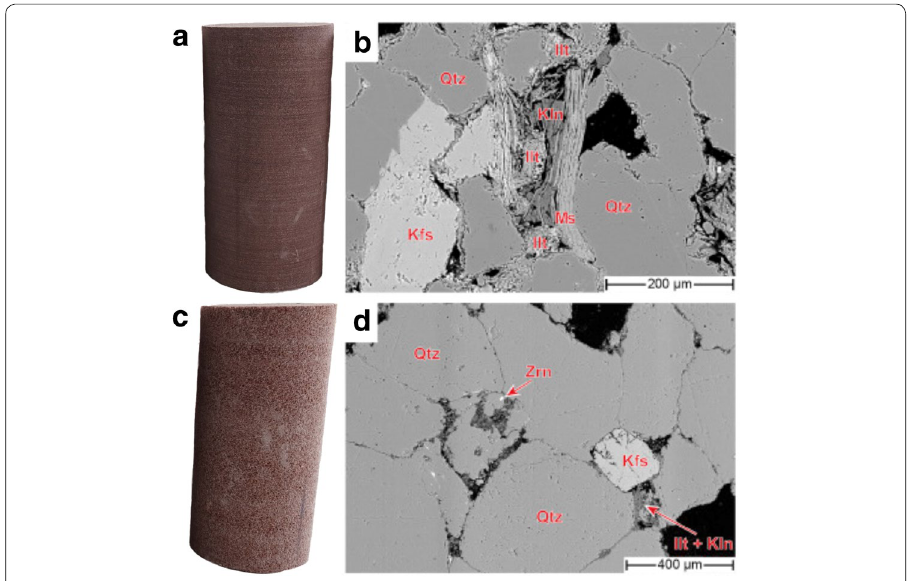
Fig. 1 Samples for the triaxial tests for a layered PfSst and c unlayered TenSst. Thin section images of b PfSst and d TenSst in BSE mode with their mineral composition and pore space (black) (after Schmidt et al. (2017)). Note the different scales